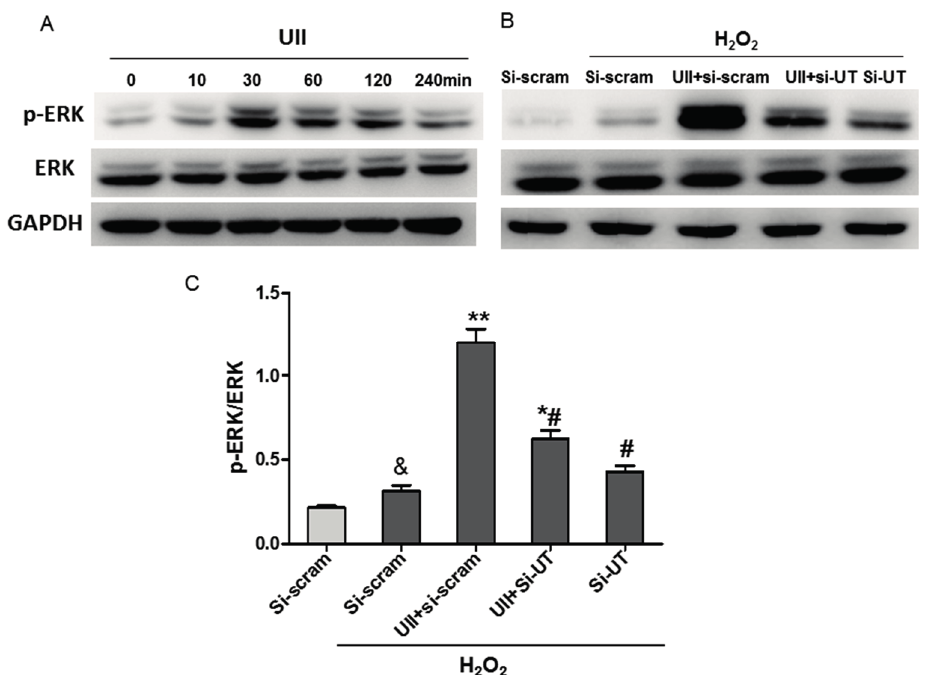
Figure 3. UII promotes the activation of ERK in cultured cardiomyocytes exposed to H 2 O 2 . ( A ) Western blot analysis of p-ERK level in cultured cardiomyocytes treated with UII at different time points (0, 10, 30, 60, 120, 240 min); ( B ) Western blot analysis of p-ERK level in cardiomyocytes; ( C ) Quantitative analysis of p-ERK/ERK level in cultured cardiomyocytes. Cardiomyocytes were transfected with si-UT or siRNA-scramble